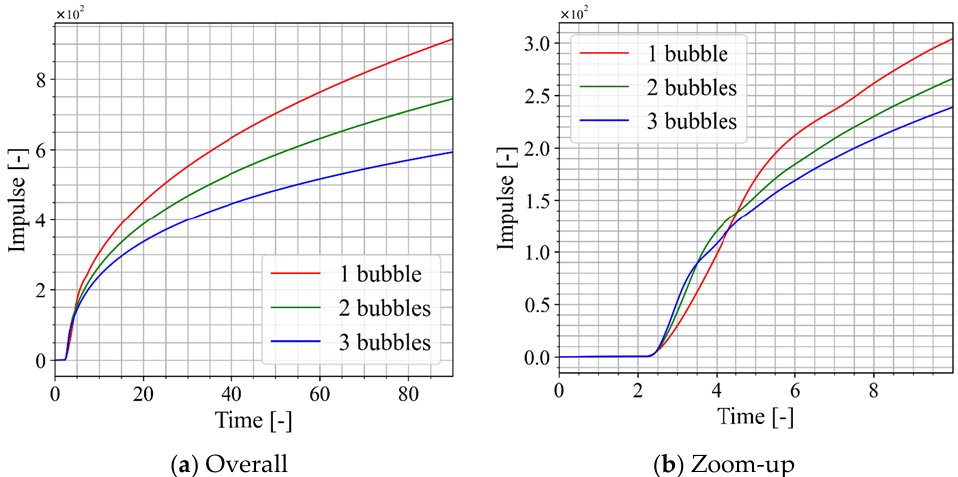
Figure 6. Time history of the impulse. This result is obtained from the simulation result of the w/o-meniscus setting.